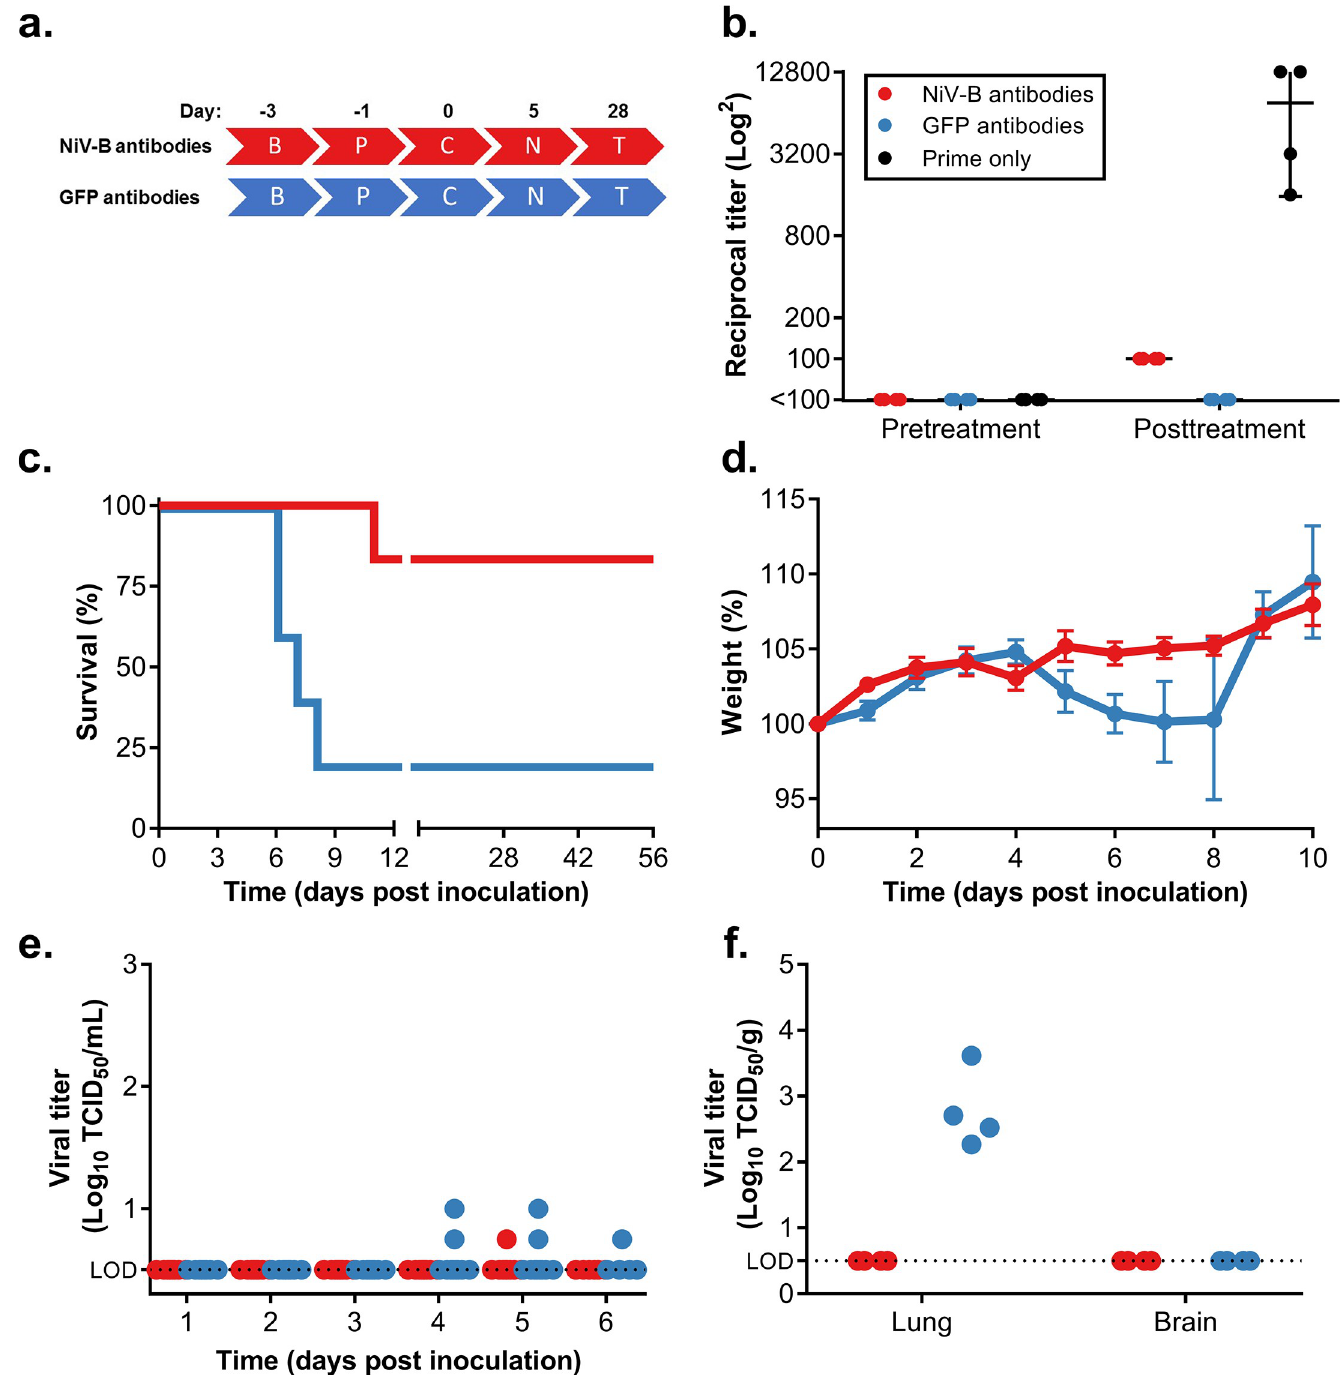
Fig 5. Treatment with ChAdOx1 NiV B elicited antibodies provides partial protection against a lethal NiV Bangladesh challenge in Syrian hamsters. (a) Experimental layout. B = bleed; P = passive transfer; C = challenge; N = necropsy; T = Termination experiment. (b) Reciprocal titer of NiV Bangladesh G protein- specific antibodies in serum as determined via ELISA at pre-treatment and post-treatment. As a control, serum obtained from animals vaccinated via prime only ( Fig 1) were taken along. (c) Survival of animals challenged with NiV Bangladesh treated with NiV or GFP antibodies. (d) Weight loss of challenged animals. (e) Shedding of infectious virus in oropharyngeal swabs collected daily from challenged animals. (f) Infectious virus titers in lung and brain tissue collected from challenged animals at D5. Virus titers were determined via endpoint titration on VeroE6 cells.